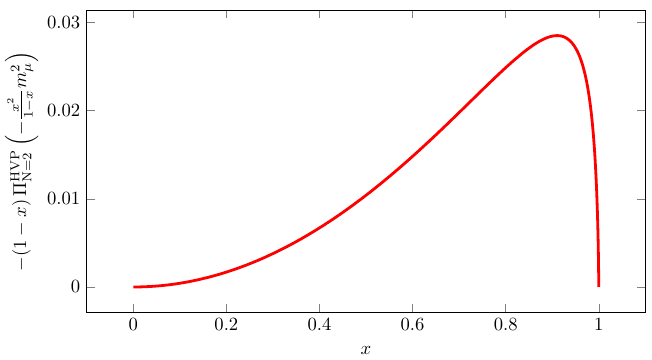
units, corresponding to the reconstruction π